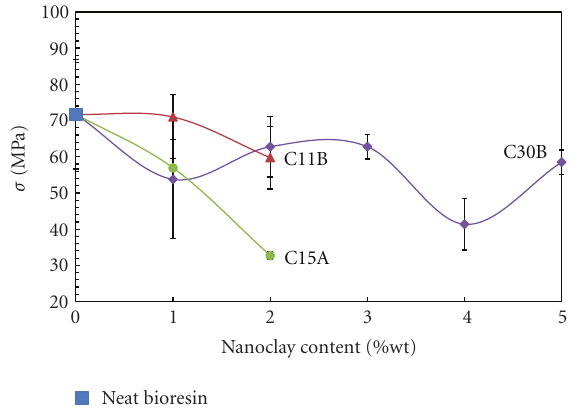
Figure 9: Ultimate strength of nanoclays reinforced polyester bioresin (matrix only).